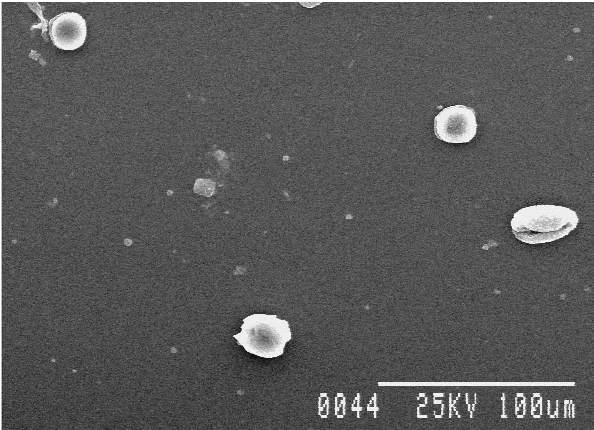
Fig. 5. X4000, showing dimorphic pollen grains of Nymphaea micrantha Guillemin et Perrottet